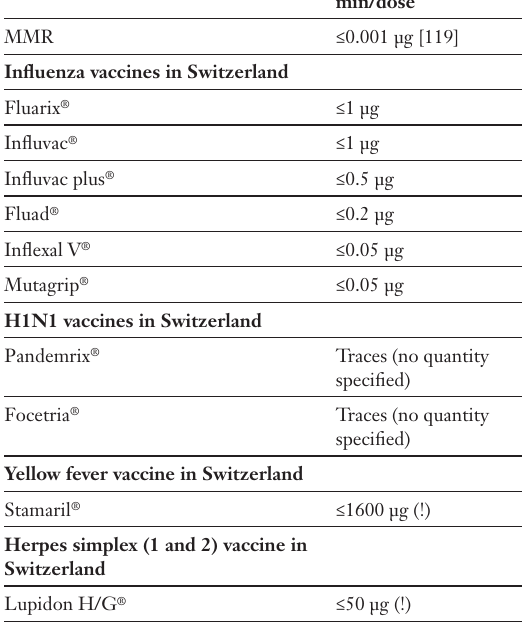
Content of ovalbu- min/dose in Switzerland (Arzneimittelkompen- dium der